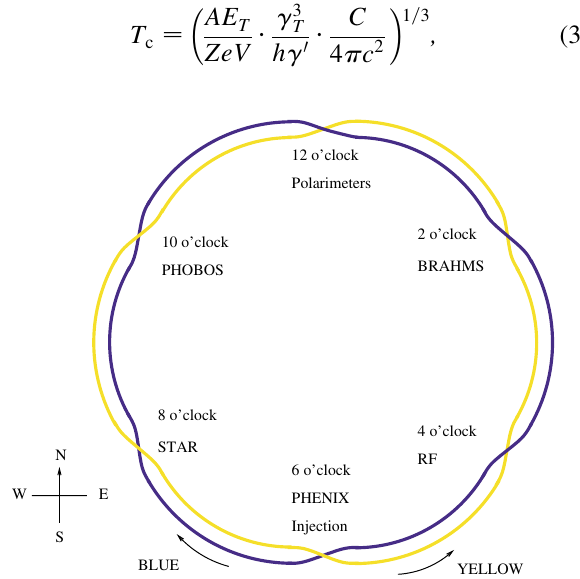
FIG. 1. (Color) Schematic view of the Relativistic Heavy Ion Collider with its two superconducting storage rings ‘‘BLUE’’ and ‘‘YELLOW,’’ intersecting at six locations around the ring circumference. During the 2002–2003 RHIC run, deuterons stored in the BLUE ring were colliding with fully stripped gold ions in the YELLOW